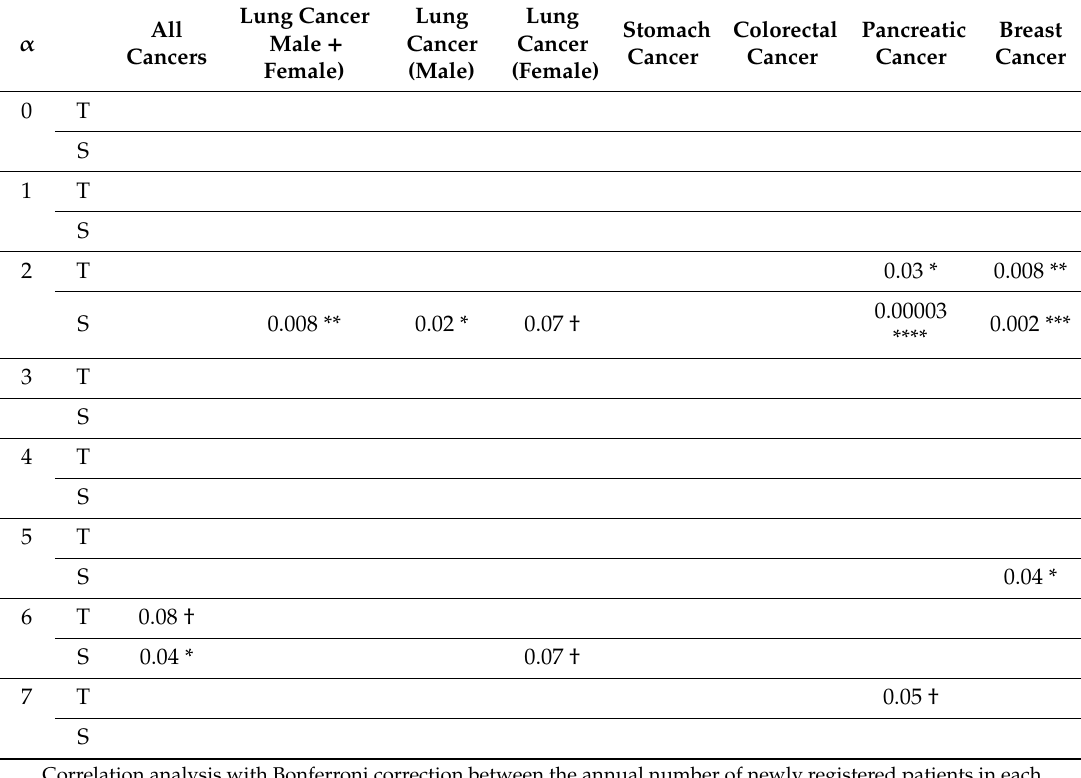
Table 1. Statistical correlations between newly registered patients with cancer and airborne pollen